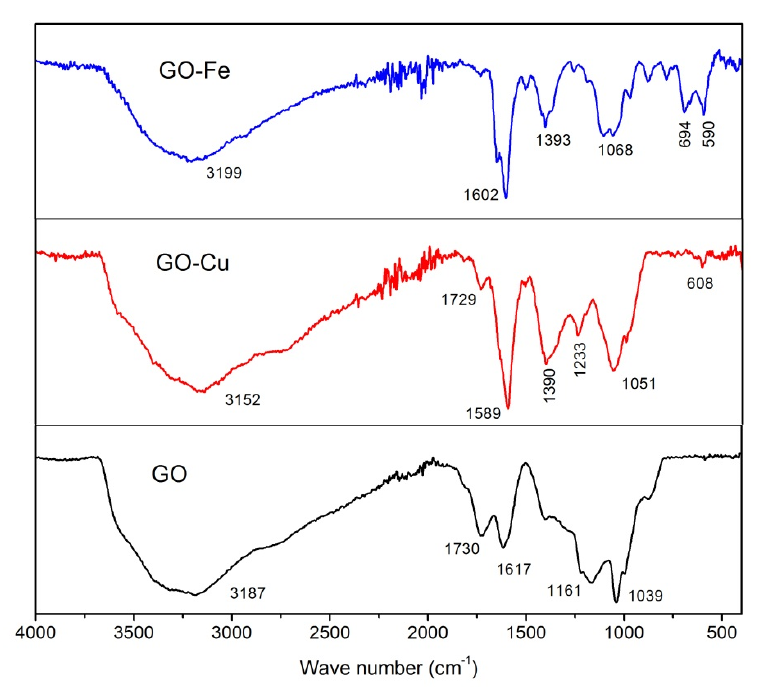
Figure 1. The fourier-transform infrared spectroscopy (FTIR) spectra of nGO, nGO-Cu and nGO-Fe.